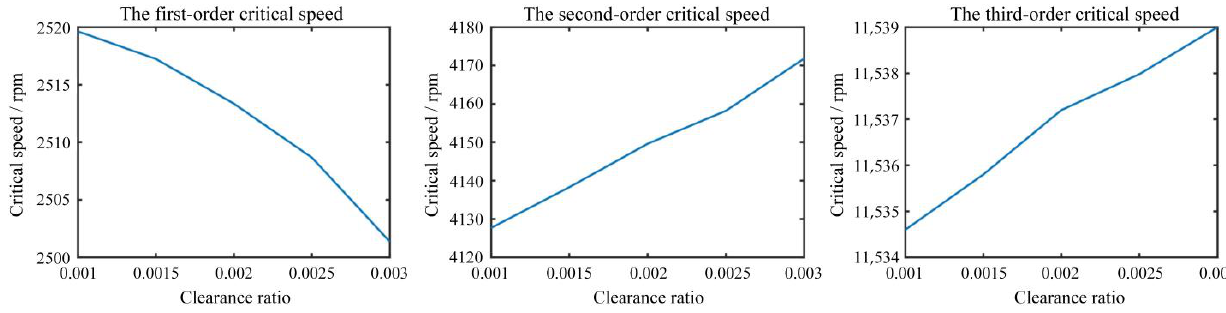
Figure 12. Influences of the clearance ratio φ on the first three critical speeds.